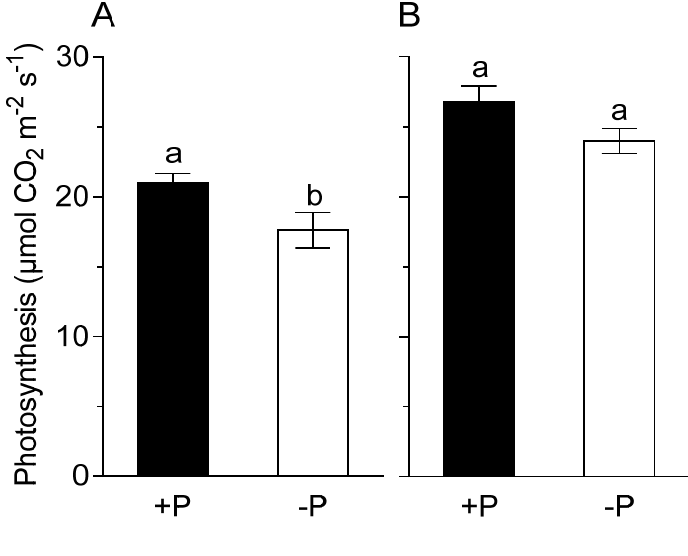
Figure 5. ( A ) Photosynthesis of sunn and ( B ) wild-type plants grown at sufficient P supply (+P) and after five to seven days of P depletion ( − P). Data are given as means of six replicates ± SE. Lower case letters indicate a significant difference between treatments ( t -test, p < 0.05, n =